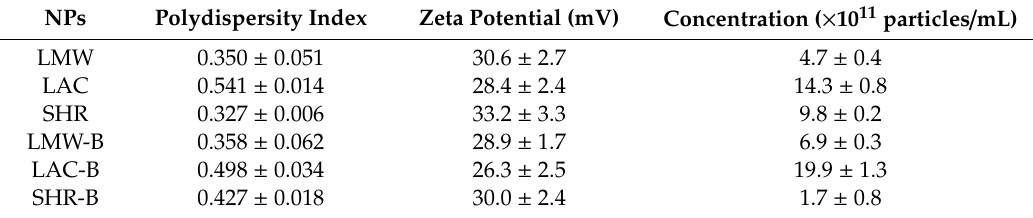
Table 2. Polydispersity index and zeta potential of chitosan and chitosan–bromelain nanoparticles obtained by DLS, laser Doppler microelectrophoresis, and NTA.